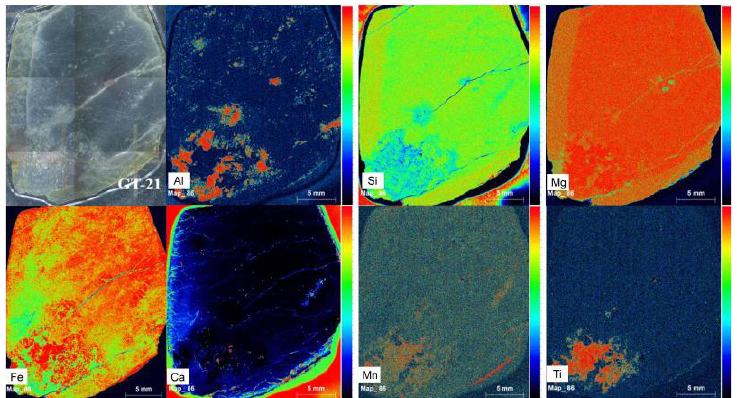
Figure 5. Elemental distribution maps made by μ -XRF mapping on a thin section with a weathering rind and an unweathered core.